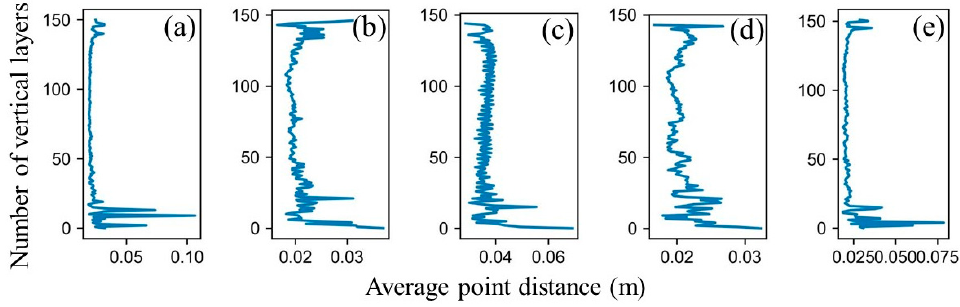
Figure 15. Vertical point distance distribution of plots with the DLS platform. ( a – e ) are the random five plots of EH overestimation at D5 planting density with cultivars A1-A5, respectively.